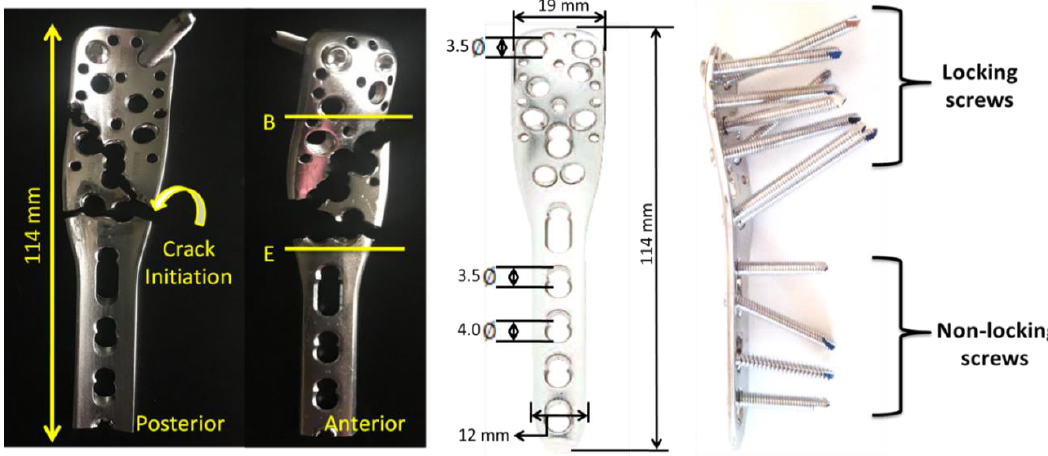
Figure 2. Anterior and posterior views of the PHILOS plate divided into six levels ( A – F ) showing the geometry, dimensions, and locking and nonlocking screw locations on the plate.